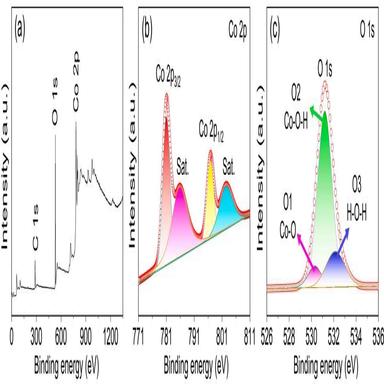
(a) The XPS wide scan spectrum of β-Co(OH)2 microflowers, and the related XPS spectra of (b) Co 2p as well as (c) O 1 s, respectively.